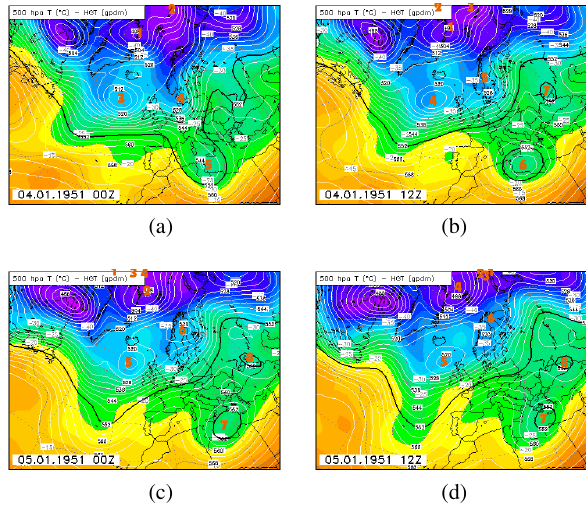
Figure 3 : As in Fig. 2, but for 4 and 5 January, 1951. Figure 3. As in Fig. 2, but for 4 and 5 January